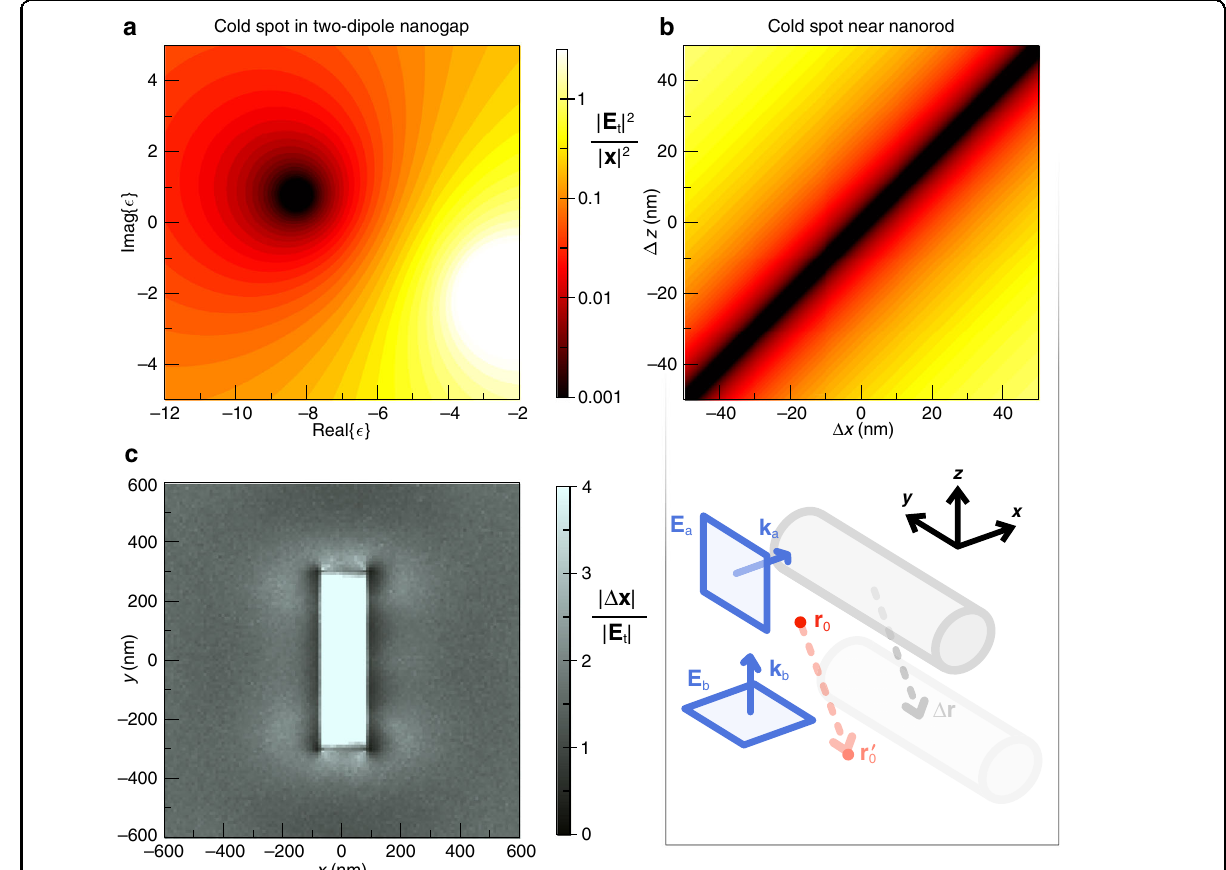
Fig. 5 Perturbation response a Response of a cold spot, positioned exactly between the two dipolar scatterers treated previously, to changes in the real and imaginary parts of the scatterers ’ permittivity. The dipoles are under constant illumination by two plane waves with amplitudes which assume ε Ag ¼ (cid:2) 8 : 28 þ 0 : 78 i . b Response of a cold spot in its relative position r 0 þ Δ r , where r 0 ¼ (cid:2) 200 ^ x nm, to a silver nanorod oriented along ^ y and originally centred at the origin, when the nanorod is displaced by a vector Δ r ¼ Δ x ^ x þ Δ z ^ z . c The total error in the illuminating plane waves, = 0 cross section of Δ x j j , which causes a unit rise in the electric fi eld magnitude in the cold spot, E t j j , calculated for every cold spot position in the z the silver nanorod of ( b ). Brighter pixels highlight positions where the cold spot is less sensitive to plane wave error, while darker pixels